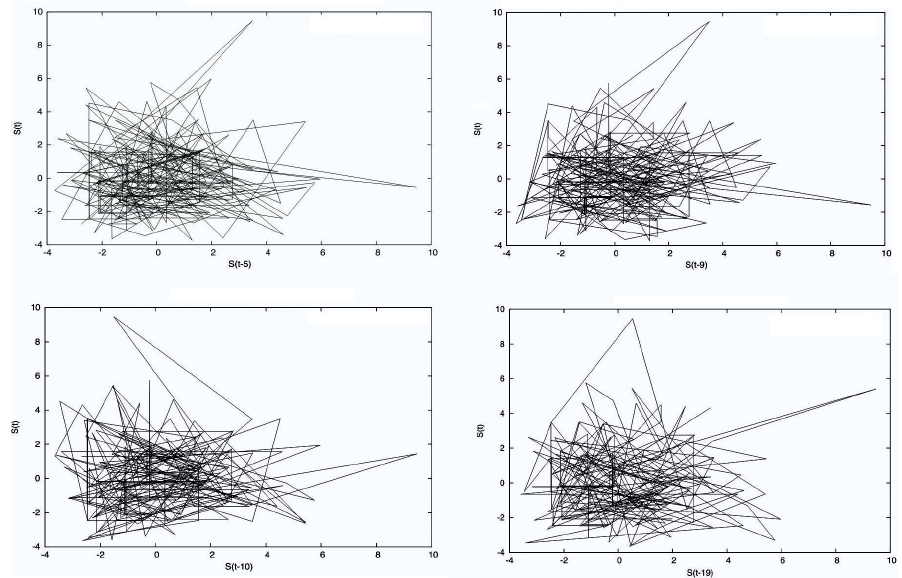
Figure 2. Phase diagrams corresponding to the time series of hurricanes that occurred between 1749 and 2012 in the Gulf of Mexico and the Caribbean Sea. The x axis in the four plots indicates the time lag ( τ